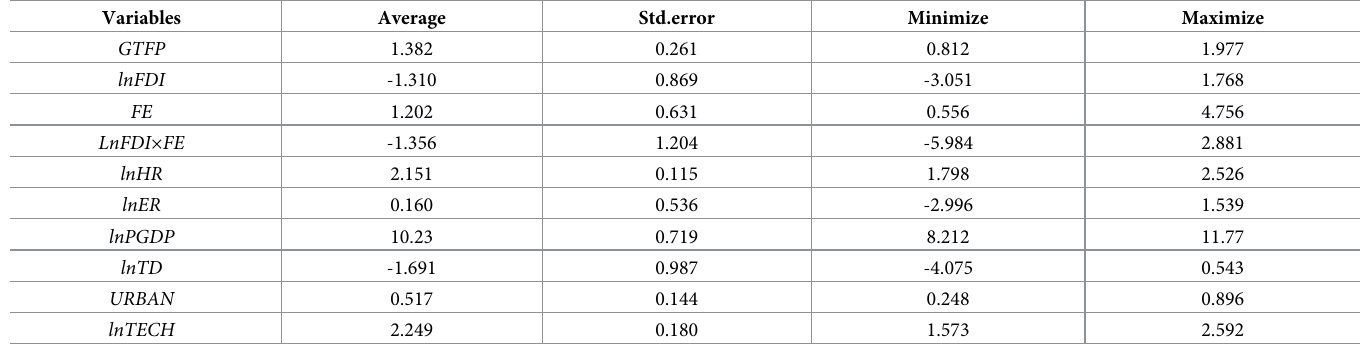
Table 4. Descriptive statistics of the explained and explanatory